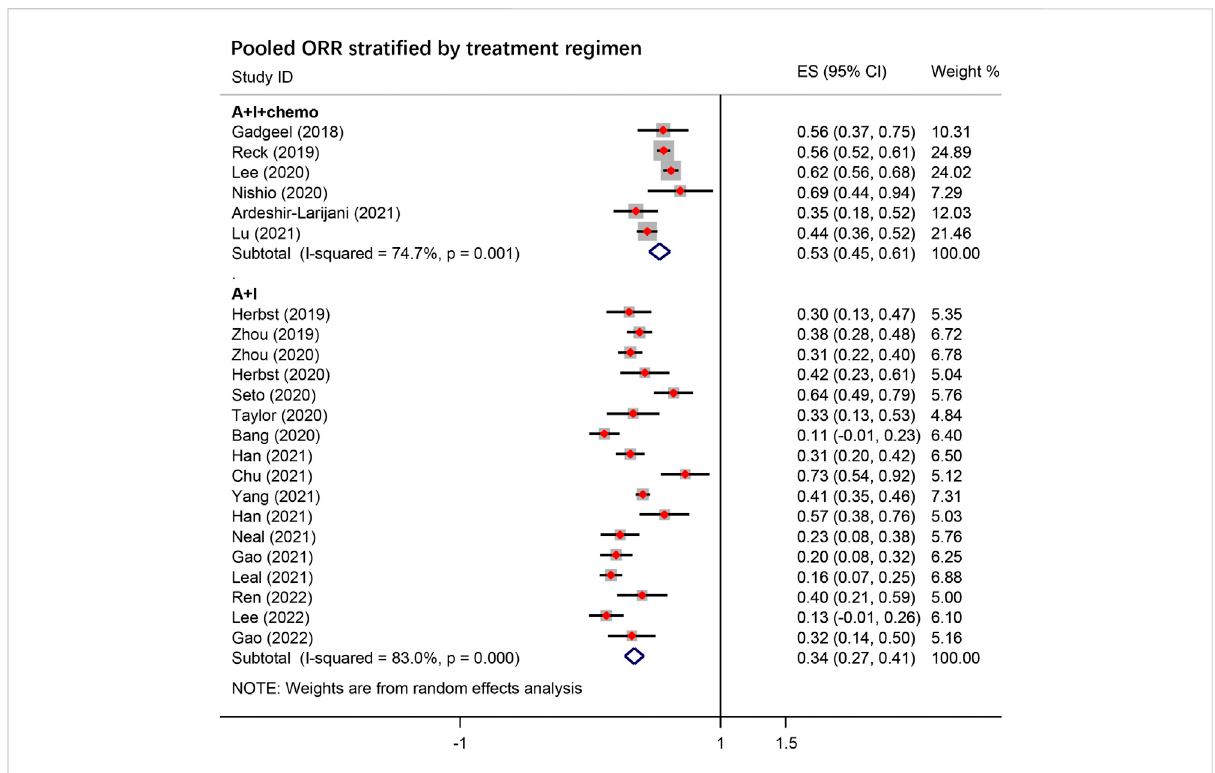
FIGURE 2 The pooled objective response rate (ORR) in the overall group strati fi ed by treatment regimen. A + I + chemo group: antiangiogenic agents combined with ICIs with chemotherapy; A + I group: antiangiogenic agents combined with